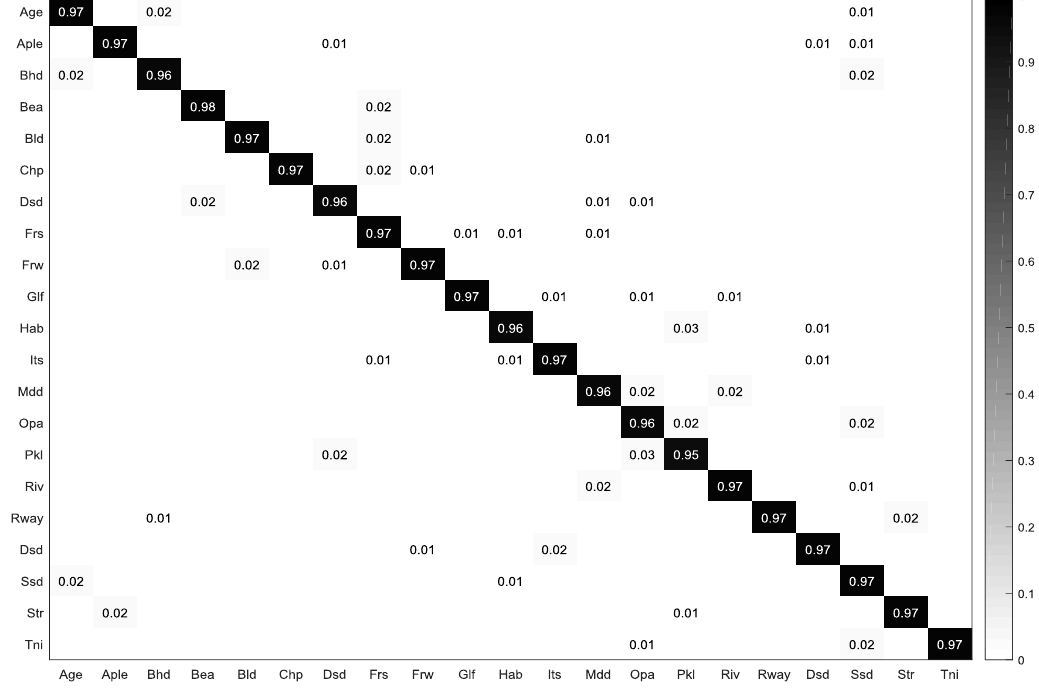
Figure 4. Confusion matrix of classification based on UC Merced